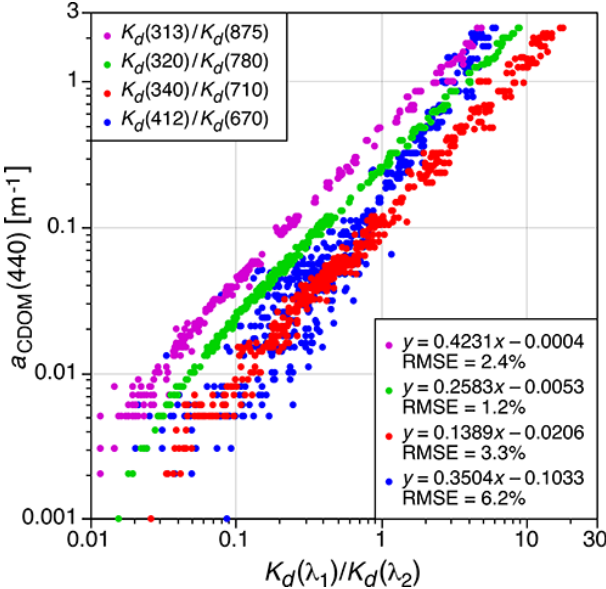
Figure 8. Four end-member algorithms to derive a CDOM ( 440 ) from in-water optical observations with the accuracy of each (considering only a linear perspective) estimated using RMSE